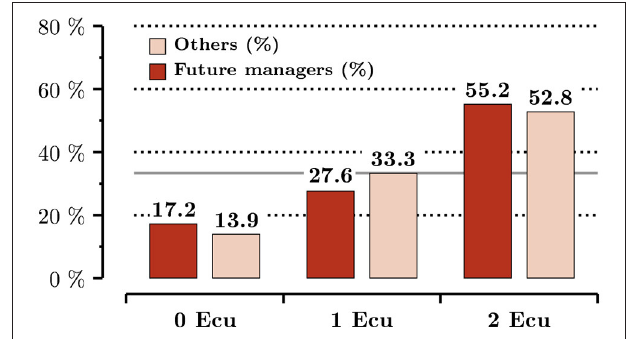
FIGURE 1 | Empirical distribution of dice draws among